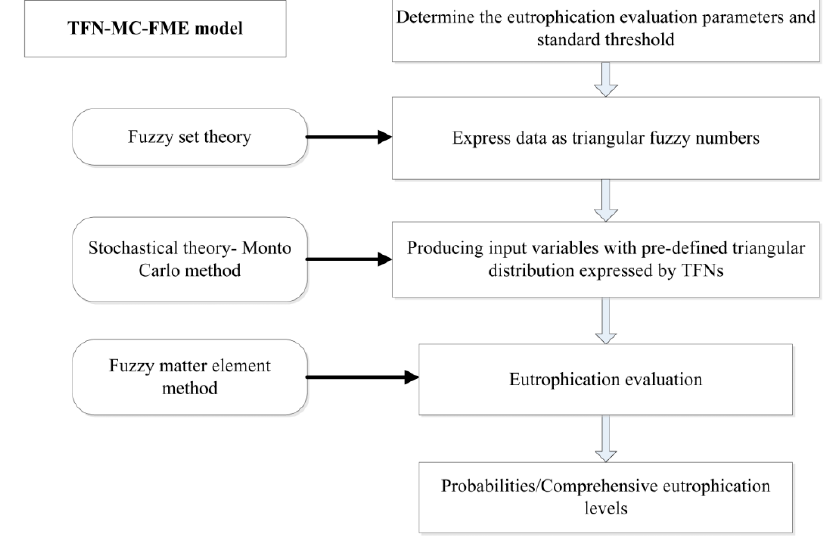
Figure 2. Flowchart of eutrophication assessment.